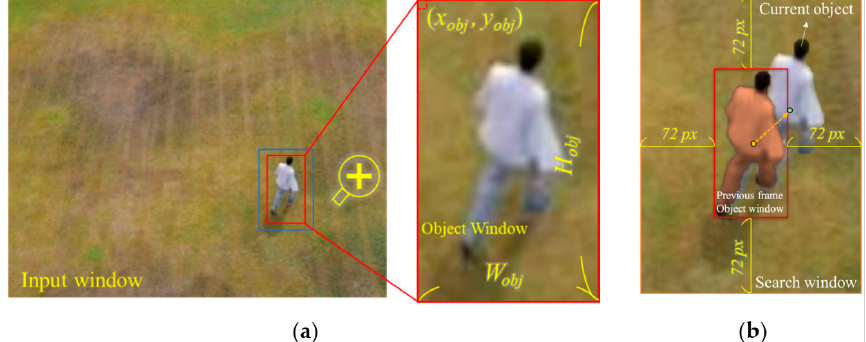
Figure 2. ( a ) Object window defines object from input window; ( b ) 72 pixels expanded search window.